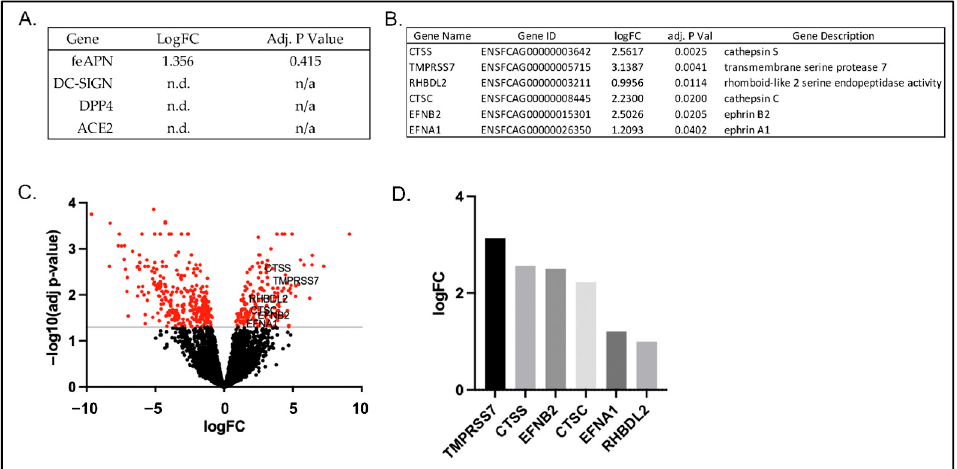
Figure 7. Genes of particular interest associated with coronavirus cell entry and/or pathogenesis. ( A ) Expression of known coronavirus cellular receptors detected or not detected in FCWF-4 CU and FCWF-4 ATCC cell lines. LogFC represents the log fold change of FCWF-4 CU gene expression relative to FCWF-4 ATCC gene expression. feAPN expression was detected in both FCWF-4 cell lines. ( B ) Six genes of interest to potentially explain differential FIPV serotype I replication. ( C ) Volcano plot of whole-transcriptome differentially expressed genes. The transcripts highlighted in red are significantly up- or down-regulated genes in FCWF-4 CU cells relative to FCWF-4 ATCC cells. Genes in ( B ) are specifically identified. ( D ) Bar graph depicting log fold change (logFC) of select genes in FCWF-4 CU cells relative to FCWF-4 ATCC cells.